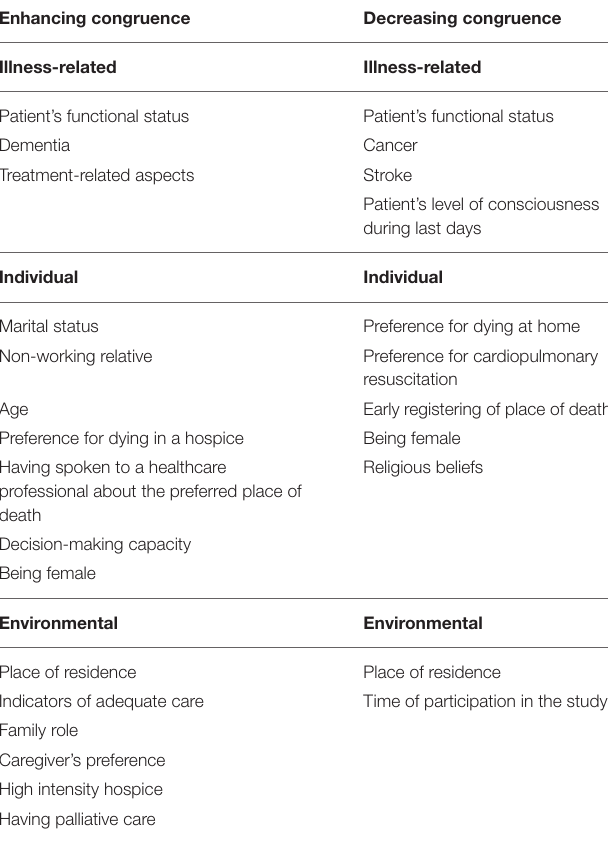
TABLE 4 | Summary of the factors affecting